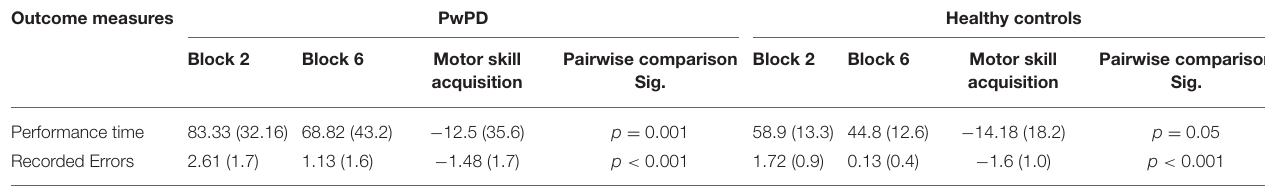
TABLE 2 | Motor skill acquisition in PwPD and healthy controls and Post-hoc analysis (Pairwise comparison) between Block 2 and Block 6. Outcome measures PwPD Healthy controls Block 6 Motor skill Pairwise comparison Block 2 Block 6 Motor skill Pairwise comparison acquisition Sig. acquisition Sig.